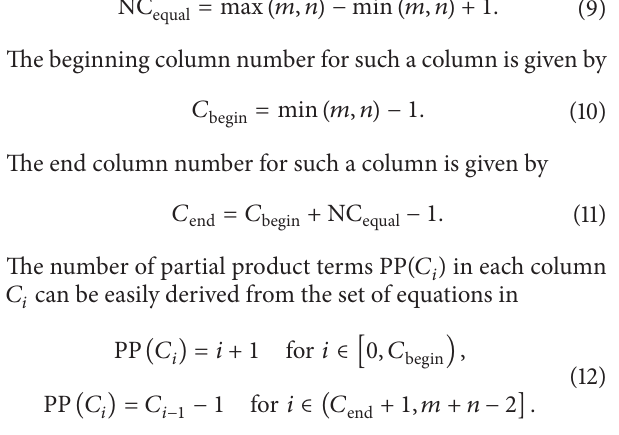
Table 9: Contributing rows for 𝑚 = 3 and 𝑛 = 5. Contributing rows (each row contributes 1 Column